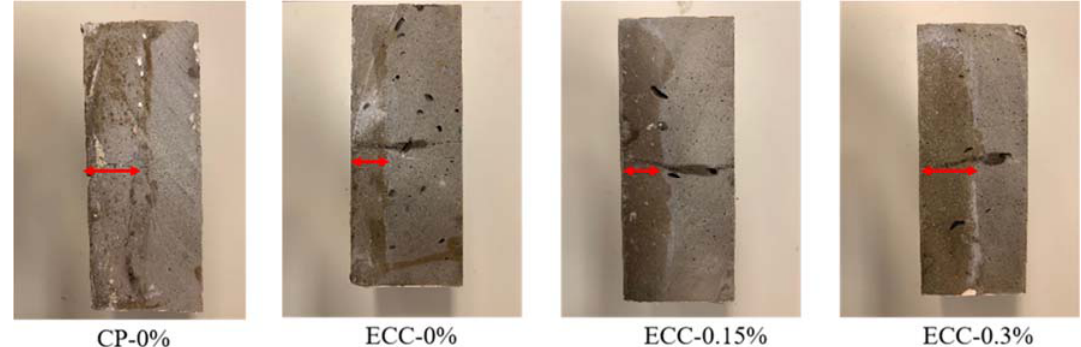
Figure 6. Chloride front migrating into CP and ECC specimens.